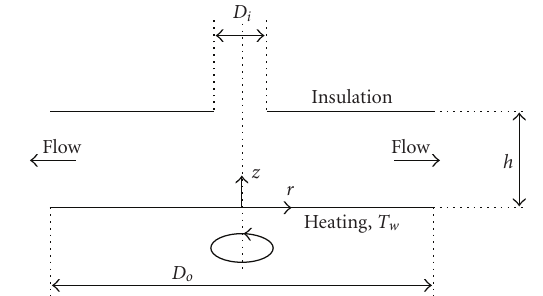
Figure 1: Schematic diagrams of two-dimensional channel wall impinged by planar dual jets and their